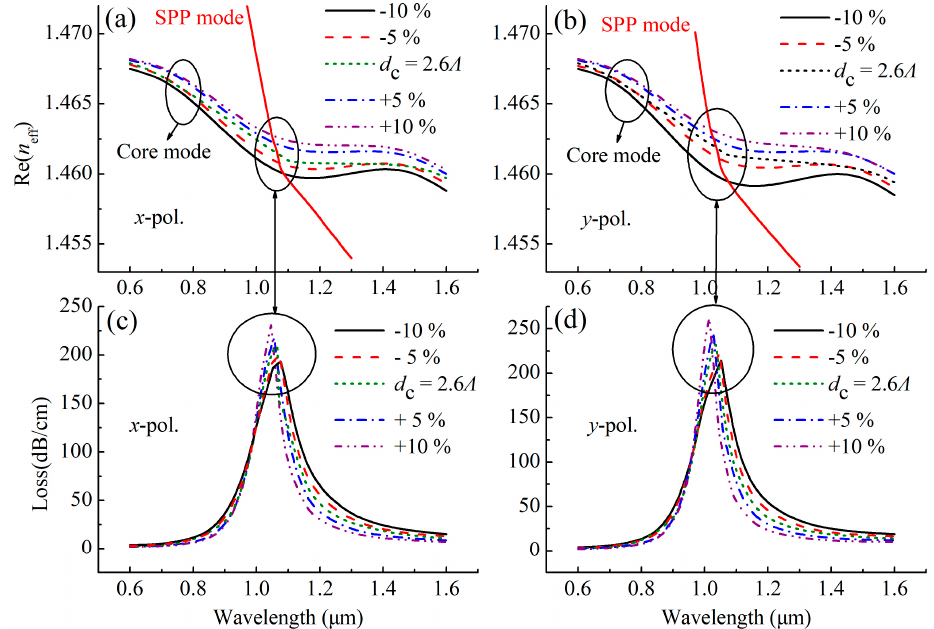
Figure 8. ( a ) Dispersion relations of the x -polarized core mode and SPP mode, ( b ) dispersion relations of the y -polarized core mode and SPP mode, ( c ) losses as a function of wavelength for the x -polarized core mode and ( d ) losses as a function of wavelength for the y -polarized core mode at n = 1.47, with varying core diameter ( d c ).